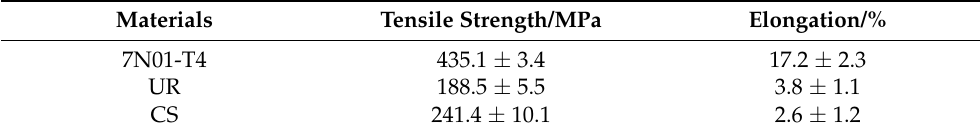
Table 2. Tensile strength and elongation of samples.